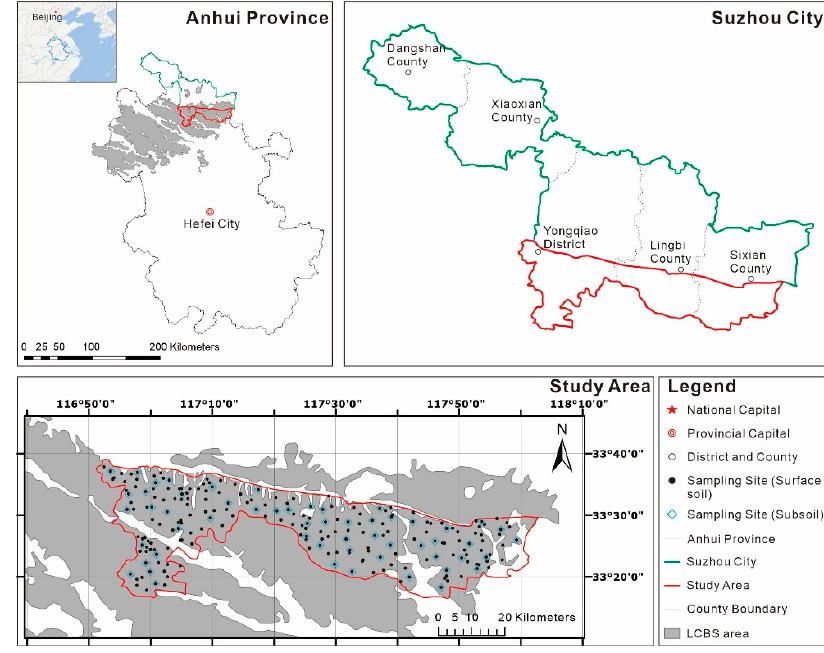
Figure 1. Study area and sampling sites.